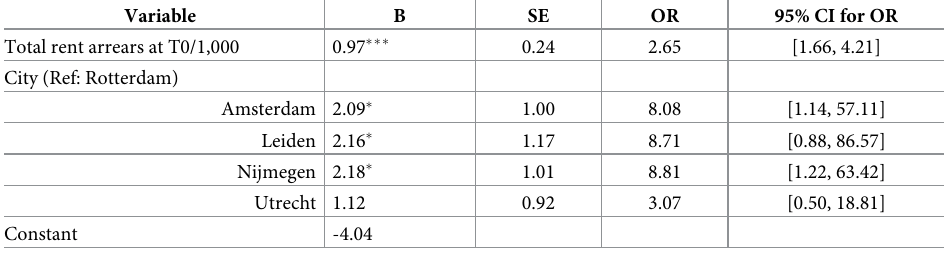
Table 5. Final multiple logistic regression model predicting receiving an eviction order for multi-person house- holds (N = 151). Variable